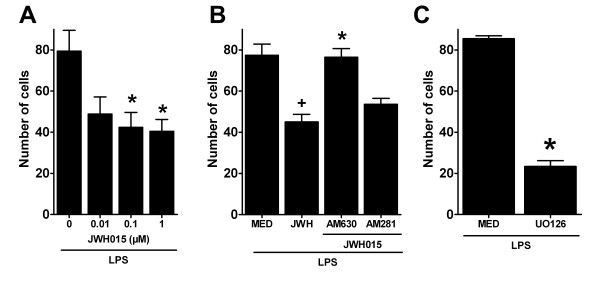
Quantification of JWH015-reduced LPS-stimulated microglial migration. (A) JWH015 reduced the number of LPS-stimulated microglia that migrated towards ADP in a dose related fashion. *p < 0.05 vs. medium control group (0) group. (B) Blockade of the effects of JWH015 (1 μM,) on microglial migration by the selective CBR2 antagonist, AM630, but not by the selective CBR1 antagonist, AM281. Data are presented as the number of cells that migrated towards ADP. +p < 0.05 vs. medium group (MED), *p < 0.05 vs. JWH015 1 μM group (JWH) group. (C) Blockade of microglial migration by the selective MEK inhibitor UO126 in LPS-stimulated microglia. UO126 (1 μM), which selectively blocked MEK and thereby ERK phosphorylation, significantly reduced the number of LPS-stimulated microglia that migrated towards ADP. *p < 0.05 vs.medium group (MED) group.